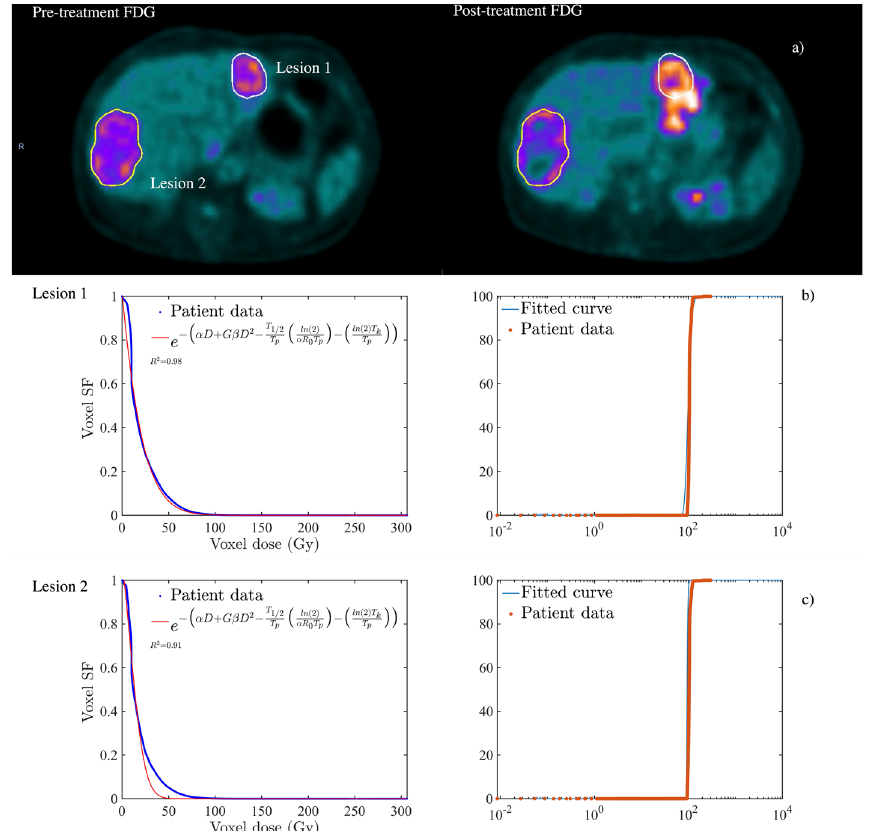
Fig. 3 Tumour cell heterogeneity within the metastatic CRC liver malignancy. a The deformably registered pre- and post-treatment [ 18 F] FDG PET images with two lesions on the right and left lobes are shown with the white contours. b , c The estimated voxel SF and TCP for both lesions. The survival fraction and TCP were calculated based on the 90 Y absorbed dose and SUV volume histograms. The radiobiological parameters were derived from the GLQ fit for each individual